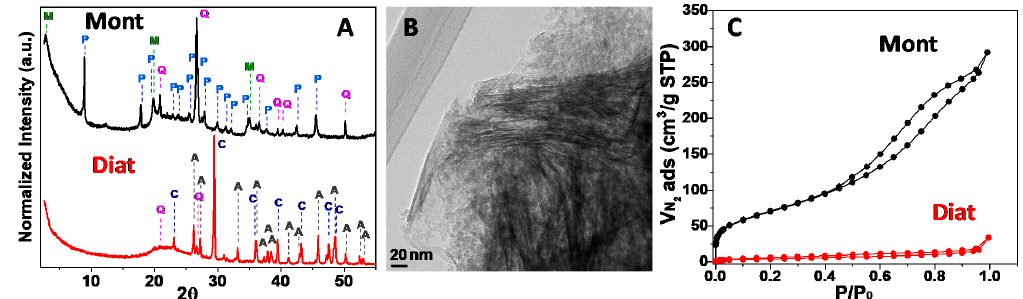
Figure 2. ( A ) X-ray diffraction ( XRD) patterns of the clays (assignment: M = montmorillonite; P = phengite; Q = α -quartz; C = calcite; A = aragonite); ( B ) transmission electron microscopy (TEM) image of the Mont; and ( C ) N 2 adsorption–desorption isotherms at − 196 °C of the clays.